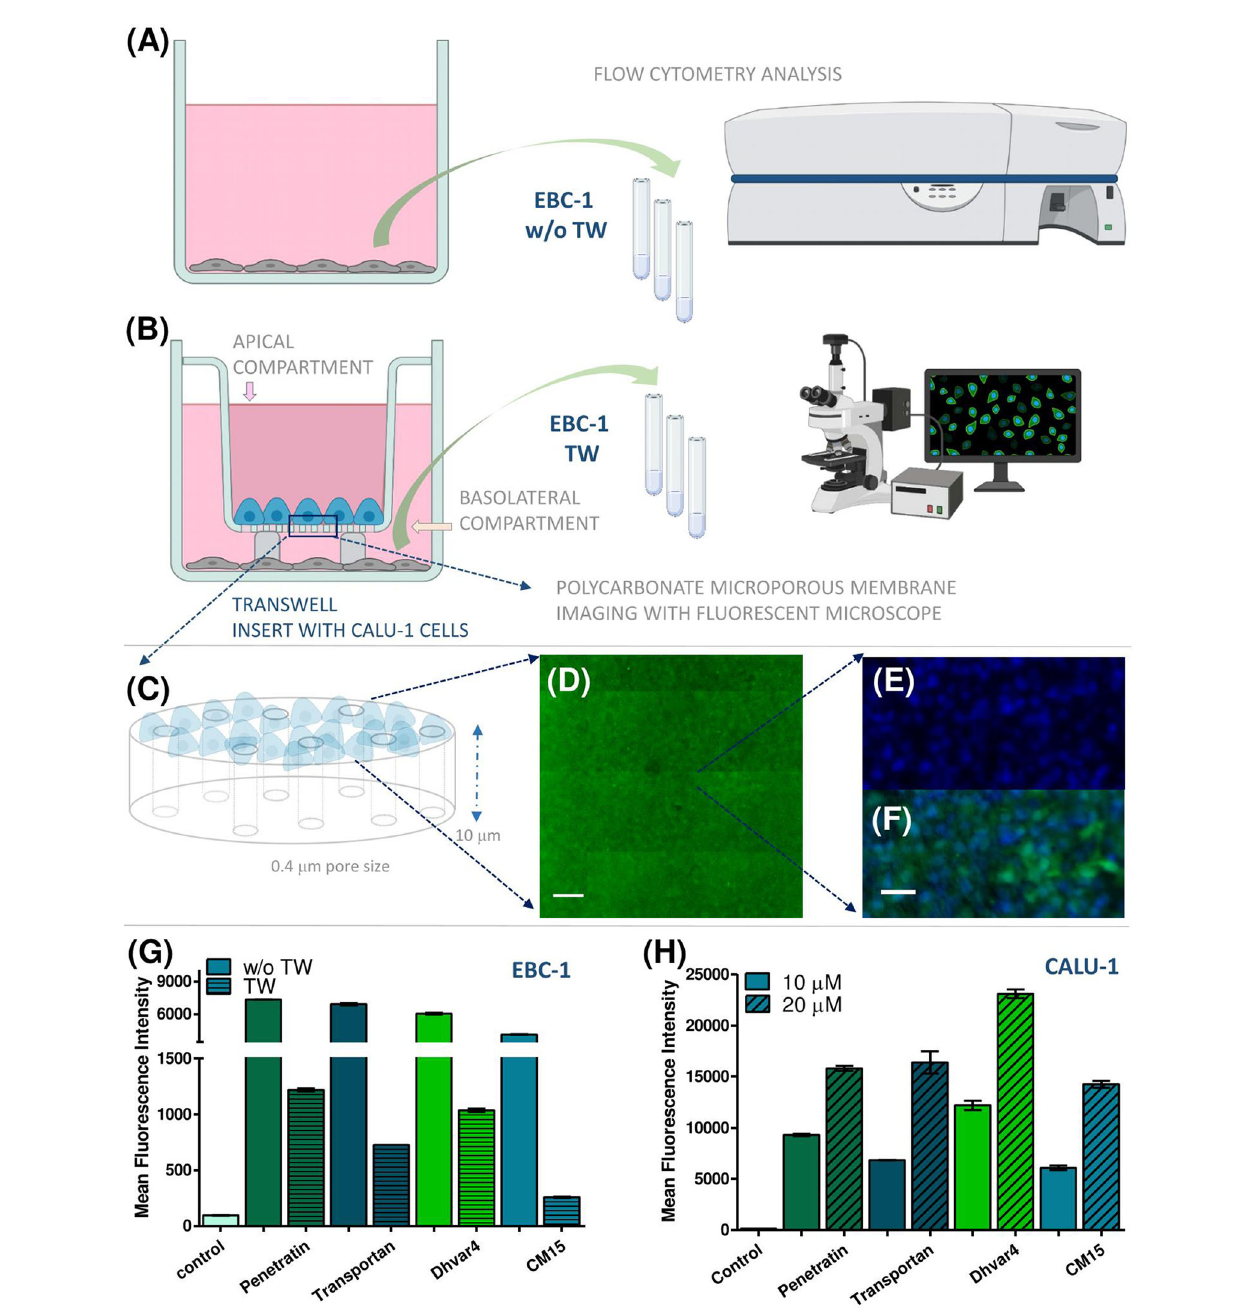
FIGURE 7 | The penetration ability of Cf -peptides was determined on Transwell bronchial interface, and the penetration rates were quanti fi ed by fl ow cytometry. Schematic representation of the Transwell coculture arrangement with noncontact submerged monolayers as simple bronchial interface model containing CALU-1 and detector EBC-1 cells (A, B) . CALU-1 cells were seeded on the apical side of the TW insert, while EBC-1 cells were seeded on the bottom of the basolateral chamber (with or without Transwell inserts) (A, B) . Schematic enlarged features of the polycarbonate microporous membrane (C) . The con fl uence of CALU-1 monolayer was monitored with CellTracker Green, and after development of stable green fl uorescence, cells were imaged in situ . Image acquisition was performed with Zeiss Axio Observer Z1 inverted epi fl uorescent microscope (×10 Plan Neo fl uar/×40 EC Plan-Neo fl uar objectives). The microscope was equipped with a Zeiss AxioCam MRm CCD camera and a Marzhauser SCAN-IM powered stage. For multi fi eld mosaic image acquisition, stage positioning and focusing were controlled by Zeiss Axiovision 4.8 software. Images were processed using NIH ImageJ software. Scale bar represents 500 µm (D) . Enlarged section of the con fl uent monolayer of CALU-1 on the polycarbonate membrane. Nuclei of the cells were stained with Hoechst 33342 (blue) and Cf peptide (green). Scale bar represents 100 µm (E, F) . The fl ow cytometry analysis of detector EBC-1 cells with or w/o Transwell inserts, MFI values presented (G) . Cellular uptake of the Cf -peptides on CALU-1 cells compared by MFI values (treatment: 3 h, 10 and 20 m M) (H)